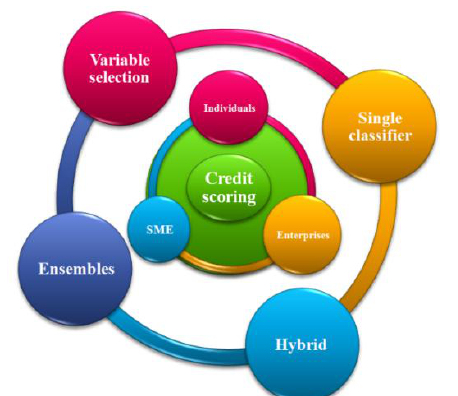
Figure 2. Classification framework for intelligent techniques in credit